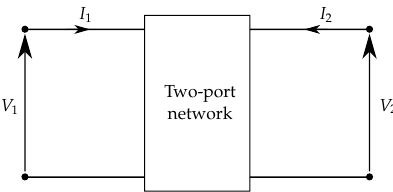
Figure 6. Two-port network.